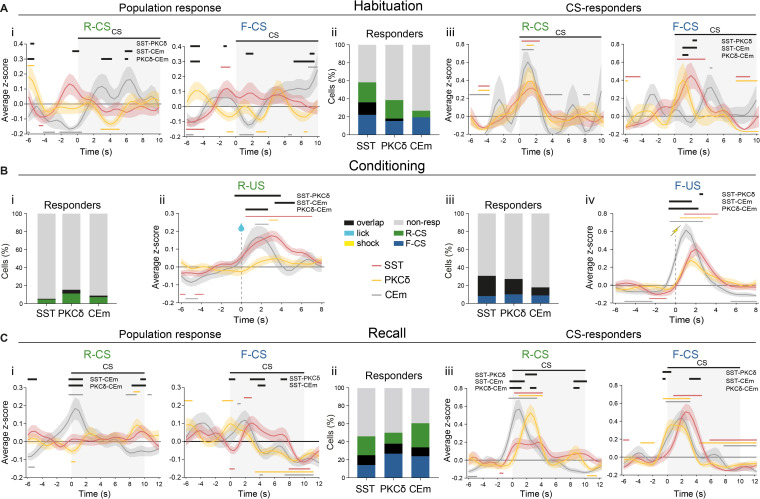
Responses to Pavlovian learning task stimuli in CE.In all panels, black lines indicate significant differences (p<0.05) between populations, as determined by Holm-Sidak post hoc analyses, while colored lines indicate significant differences (p<0.05) from zero for each population, as determined by one-sample t-tests. All data presented as mean ± SEM. (A) (i) PETH of CS-evoked population responses of CE subpopulations for (left) R-CS (significant time x population interaction in a two-way RM ANOVA, F64,3232=2.76, p<0.0001) and (right) F-CS (significant time x population interaction in a two-way RM ANOVA, F64,4032=2.43, p<0.0001) at habituation. (ii) Percentage of neurons responsive to task stimuli, as determined by trial-averaged neuronal responses above a z-score of 1.65 at habituation. (iii) PETH of CS-evoked population responses of CE responders (from ii) for (left) R-CS (significant effect of time in a two-way RM ANOVA, F32,800=7.436, p<0.0001) and (right) F-CS (significant time x population interaction in a two-way RM ANOVA, F64,1056=1.721, p=0.0005) at habituation. (B) (i) Percentage of neurons responsive to task stimuli, as determined by trial-averaged neuronal responses above a z-score of 1.65 in RC. (ii) Average z-scored population responses of CE subpopulations as PETH upon R-US (significant time x population interaction in a two-way RM ANOVA, F56,3976=2.45, p<0.0001). (iii) Percentage of neurons responsive to task stimuli, as determined by trial-averaged neuronal responses above a z-score of 1.65 in FC. (iv) Average z-scored population responses as PETH of CE subpopulations upon F-US (significant time x population interaction in a two-way RM ANOVA, F56,4480=4.22, p<0.0001). (C) PETH of CS-evoked population responses at recall of CE subpopulations for (left) R-CS (significant time x population interaction in a two-way RM ANOVA, F72,9684=2.81, p<0.0001) and (right) F-CS (significant time x population interaction in a two-way RM ANOVA, F72,9072=2.01, p<0.0001). (ii) Percentage of neurons responsive to task stimuli, as determined by trial-averaged neuronal responses above a z-score of 1.65 at recall. (iii) PETH of CS-evoked responses at recall of CE responders (from ii) for (left) R-CS (significant time x population interaction in a two-way RM ANOVA, F72,2952=3.577, p<0.0001) and (right) F-CS (significant time x population interaction in a two-way RM ANOVA, F72,3240=2.273, p<0.0001) at recall. All data presented as mean ± SEM. Full statistical report in Appendix 1—table 1.